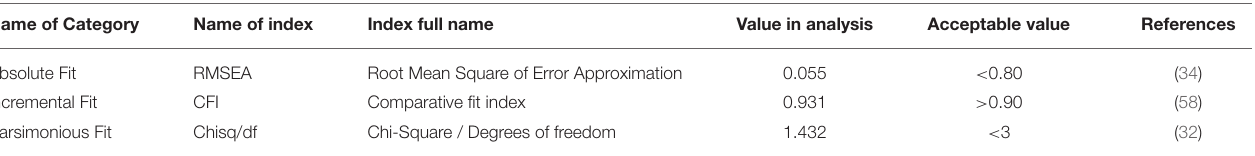
TABLE 3 | Pooled confirmatory factor analysis (CFA) model fitness